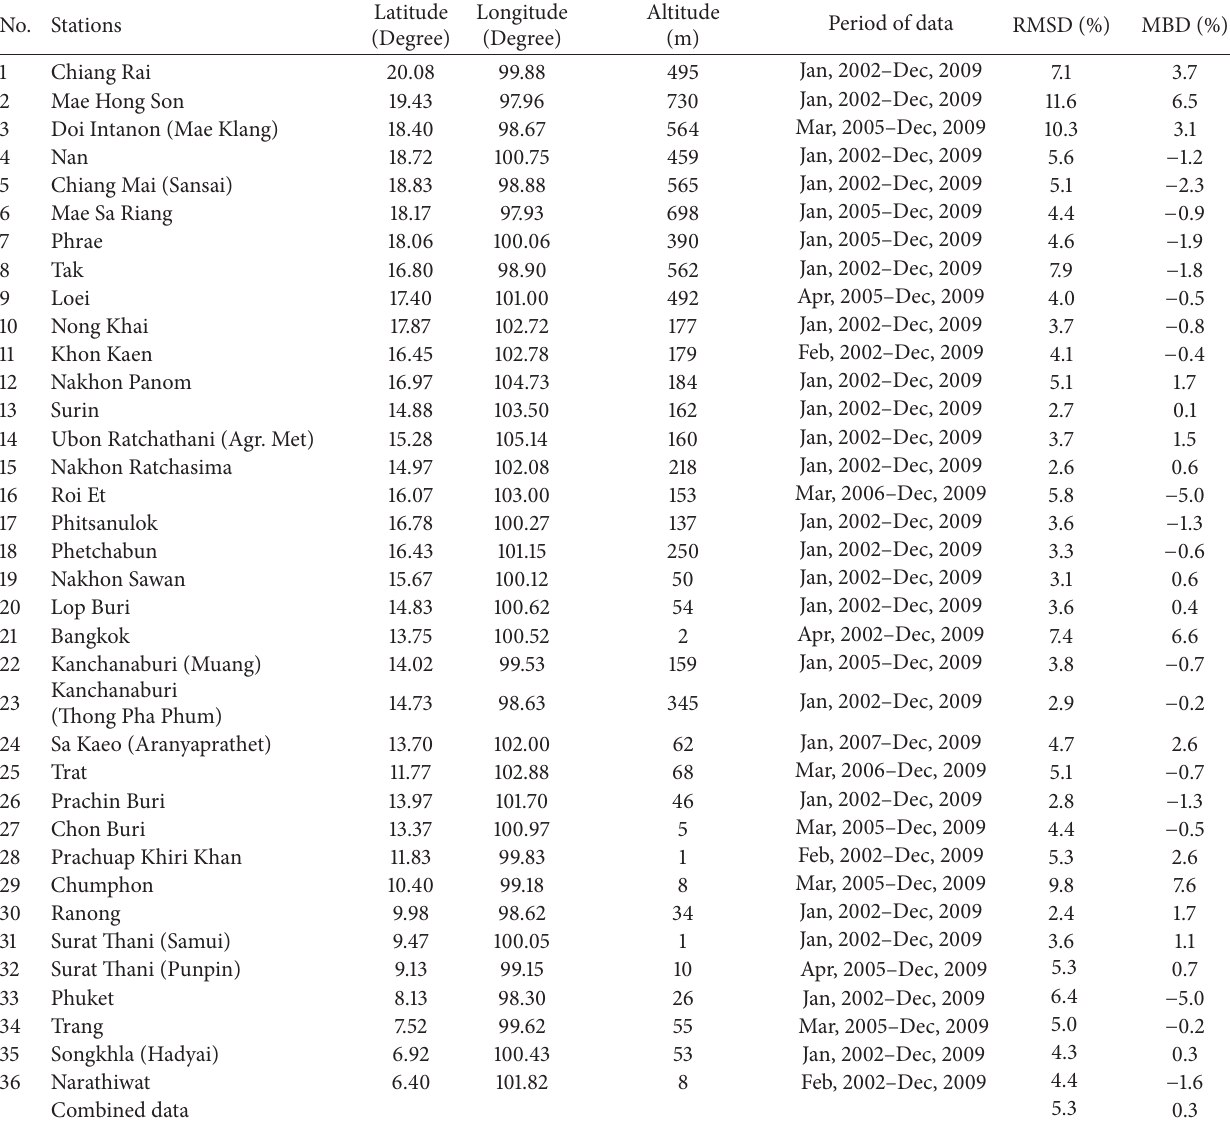
Table 3: Names, latitudes, longitudes of measurement stations, and period of data. Also shown in this table are the values of root mean square different (RMSD) and mean bias difference (MBD) obtained from the comparison between the model and measured long-term monthly average daily